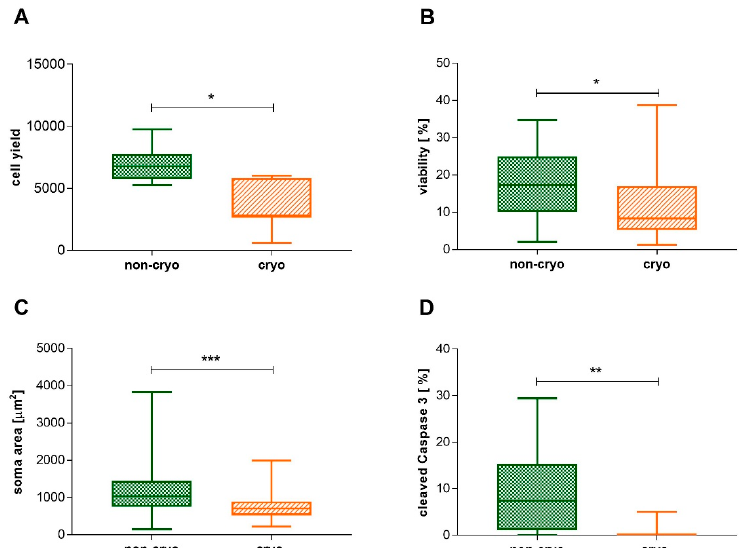
Figure 2. A: Y axis: neuronal cell yield [number of neurons] in cell suspensions after isolation/thawing, respectively. Cryo cultures show reduced neuronal cell yield when compared to non-cryo cultures. Non-cryo and cryo: n = 8 dogs. B: Y axis: neuronal viability [%] at 6 DiV. Cryo neurons show reduced